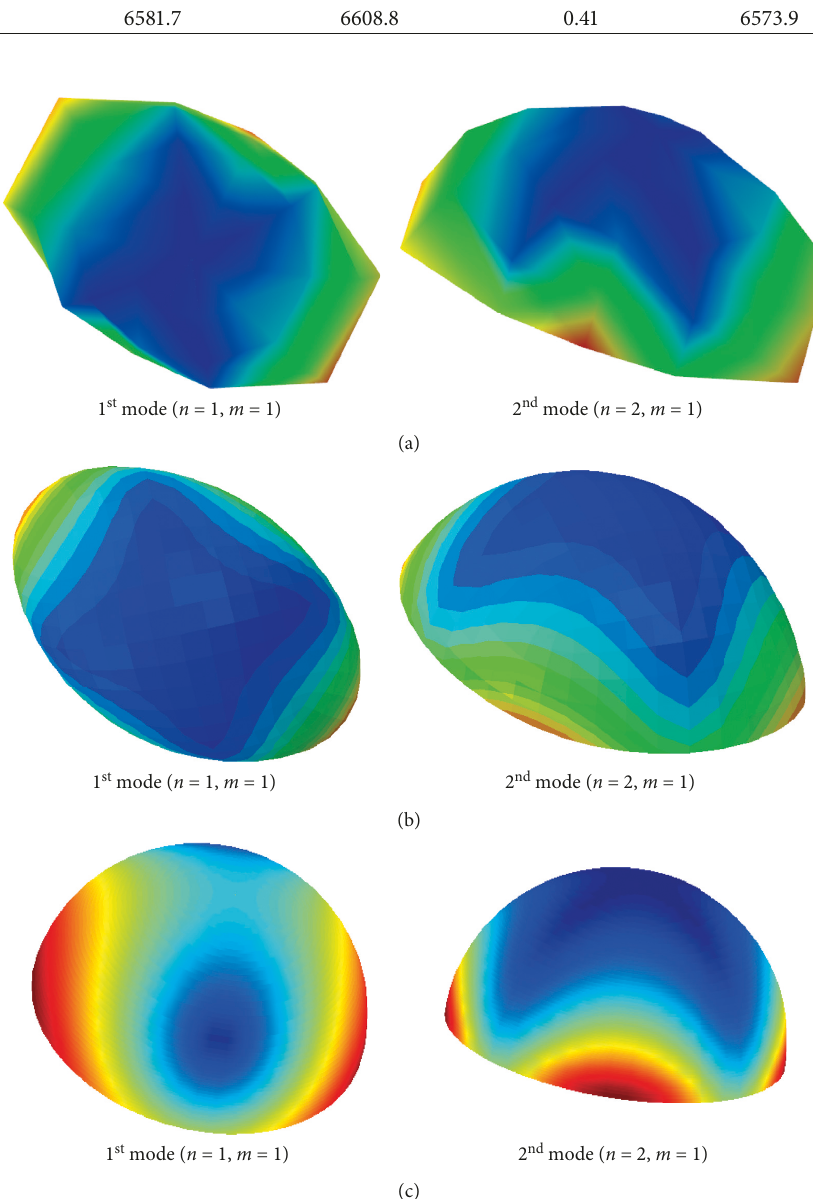
Figure 7: Typical mode shapes of the spherical cap with free edge conditions using different methods. (a) Typical model test mode shapes of the spherical cap with free boundary restraint. (b) Typical mode shapes of the spherical cap with free boundary restraint using FEM software. (c) Typical mode shapes of the spherical cap with free boundary restraint using the current